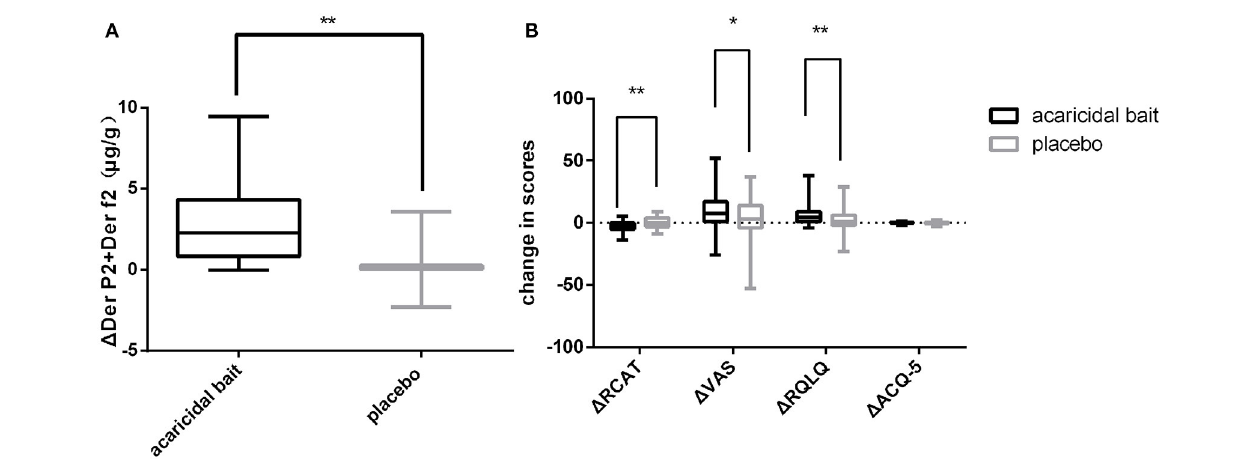
FIGURE 4 | After 8 weeks of use, a comparison of 1 Der p2 + Der f2 (A) , 1 RCAT, 1 VAS, 1 RQLQ and 1 ACQ-5 (B) between the placebo and acaricidal bait groups. Boxes indicate the median, and whiskers represent the maximum value to minimum value. 1 Der p2 + Der f2 = pretreatment dust mite antigen concentration subtracted from the posttreatment dust mite antigen concentration. 1 RCAT, 1 VAS, 1 RQLQ and 1 ACQ-5 = pretreatment scores subtracted from the posttreatment scores. * P<0.05, ** P<0.01 .